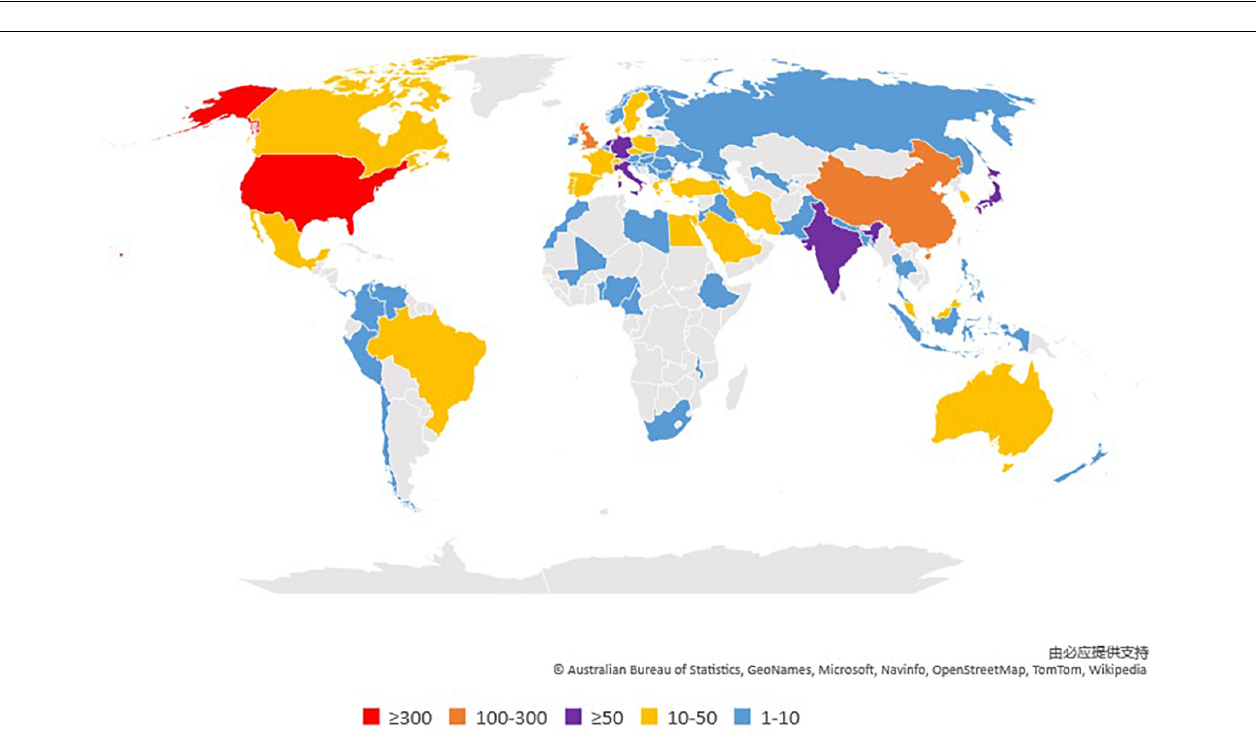
FIGURE 6 | The analysis of countries and institutions. (A) Network diagram of countries worked on DPNP research. (B) Network diagram of institutions worked on DPNP research.